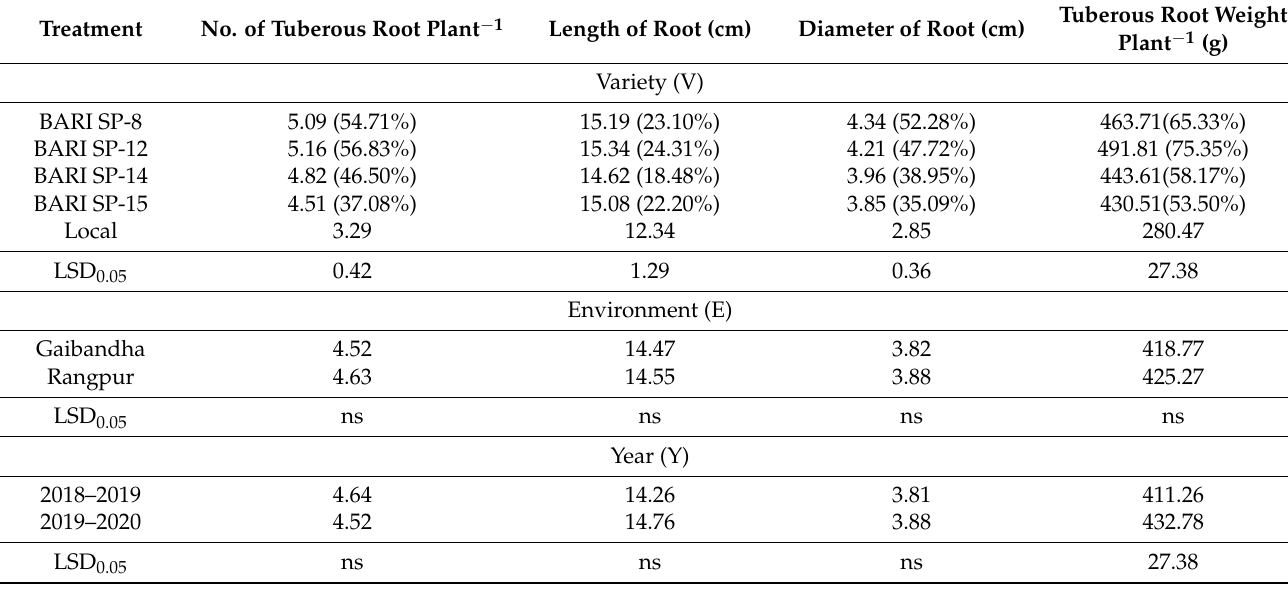
Table 4. Effect of Variety, environment, and growing season on no. of tuberous roots plant − 1 , length of root, the diameter of root and tuberous root yield plant − 1 .